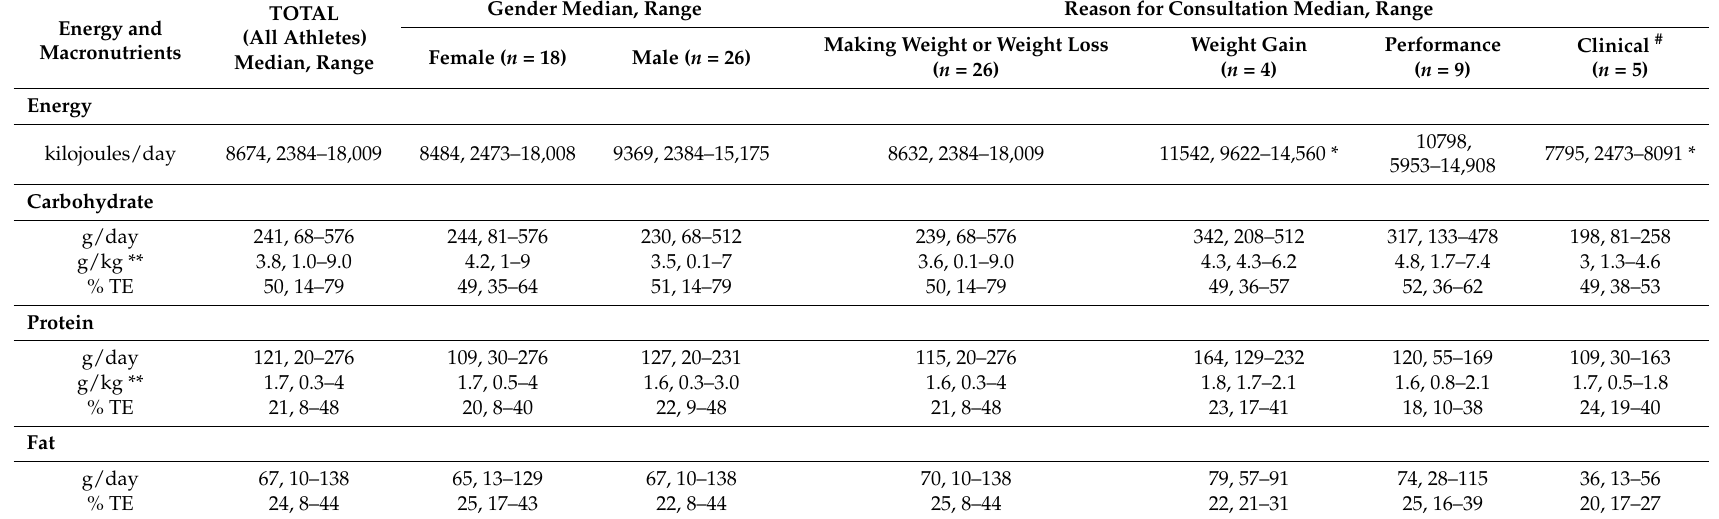
Table 2. Energy and macronutrient intake of